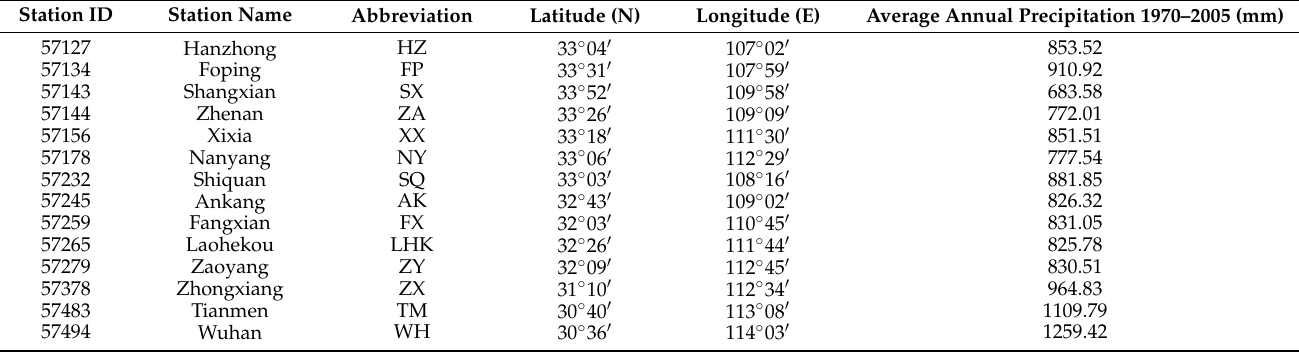
Table 1. HRB stations and their associated